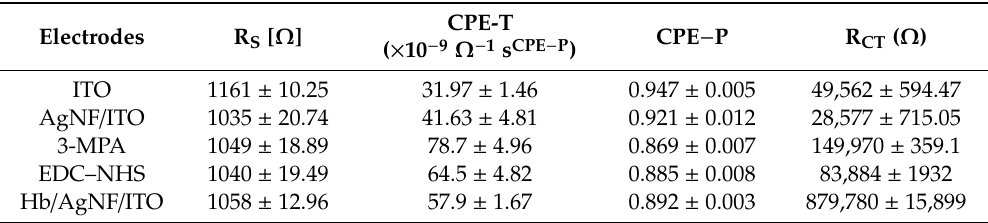
Figure 4. Bode plots of ( a ) impedance magnitude ( | Z | ) and ( b ) phase ( Φ ) vs. frequency ( f ) for bare ITO and AgNF / ITO electrodes, 3-MPA self-assembled monolayer (SAM) formation, EDC–NHS activation, and Hb binding. Measurements were performed in 10 mM (Fe(CN) 6 ) 3 − / 4 − with 0.1 M KCl as background electrolyte. The inset of ( a ) shows the modified Randles equivalent circuit used to fit the measured data. Table 1. Extrapolated parameters from Randles circuits fitted with impedance data measured at each step of the electrode SAM formation shown in Figure